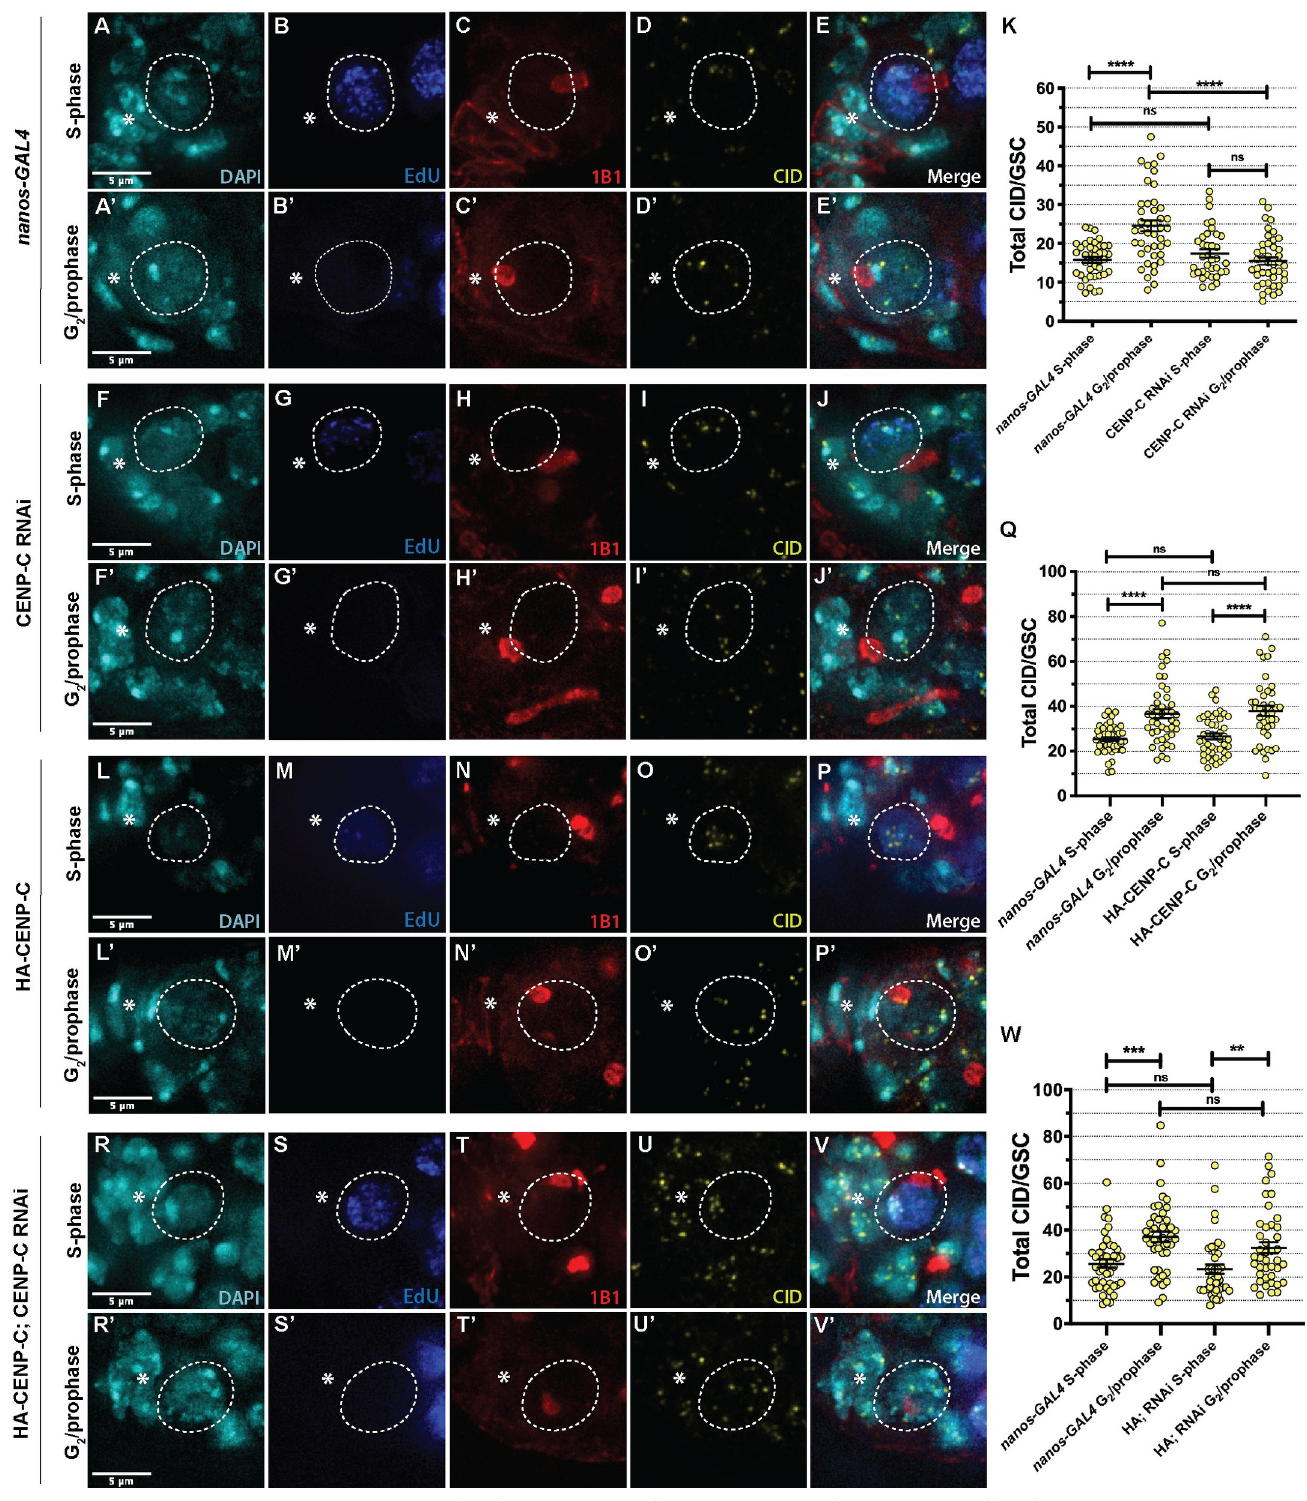
Fig 2. CENP-C is required for CID assembly in GSCs. (A-E’) nanos-GAL4, (F-J’) CENP-C RNAi, (L-P’) HA-CENP-C and (R-V’) HA-CENP-C; CENP-C RNAi (rescue) stained with DAPI (cyan), EdU (blue), 1B1 (red) and CID (yellow). S-phase GSCs (A-E, F-J, L-P, R-V) are positive for EdU, contain a bridge spectrosome and clustered centromeres. G 2 /prophase GSCs (A’-E’, F’-J’, L’-P’, R’-V’) are EdU negative, contain a round spectrosome and dispersed centromeres. The